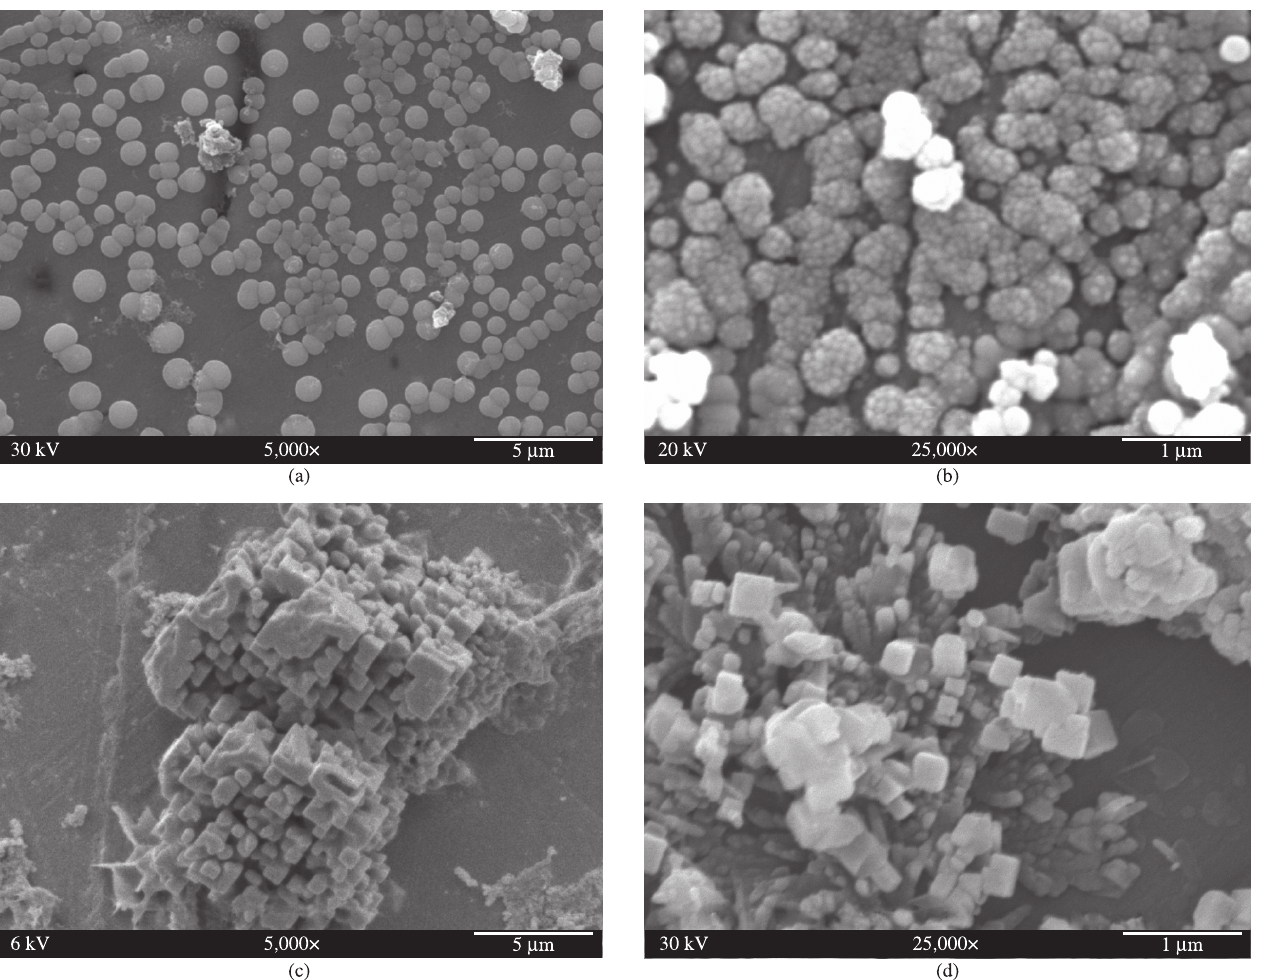
Figure 3. Scanning electron micrographs at different magnifications of sample B1-L100: a) spheroidal shape 5000× b) spheroidal shape 25000× c) cubic shape 5000× d) and cubic shape